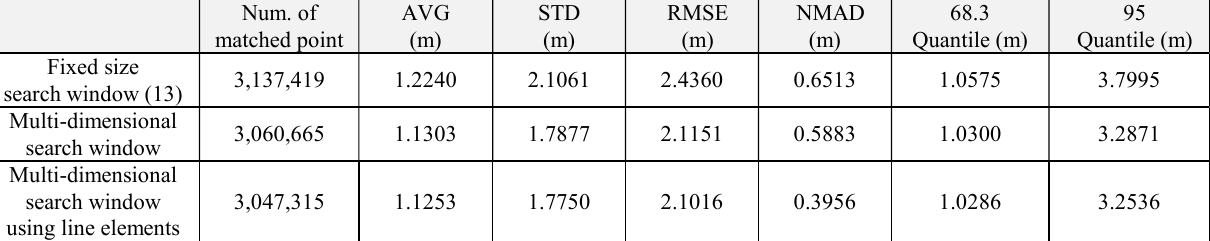
Table 2. The performance comparison with multi-dimensional search window using line